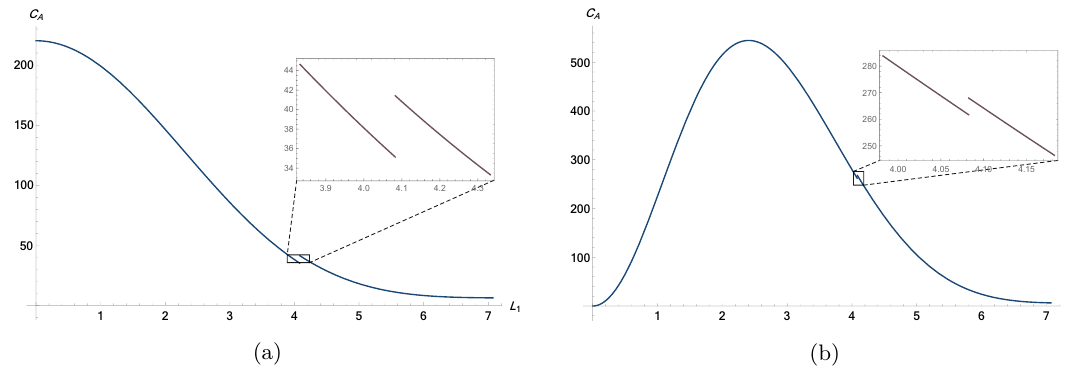
Figure 10. Complexity plots of 3 boundary island model for two choices of